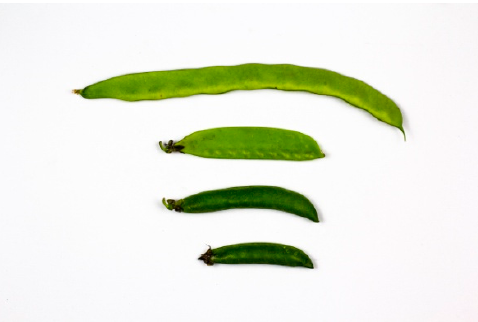
Figure 1. Plant material tested (from top to bottom): French bean “Helda” ( Phaseolus vulgaris L.), mangetout “Tirabí” ( Pisum sativum L. ssp. arvense ), pea cv. Lincoln ( Pisum sativum L.) and pea cv. BGE*-033620 ( Pisum sativum L.). * BGE: Spanish germplasm bank.